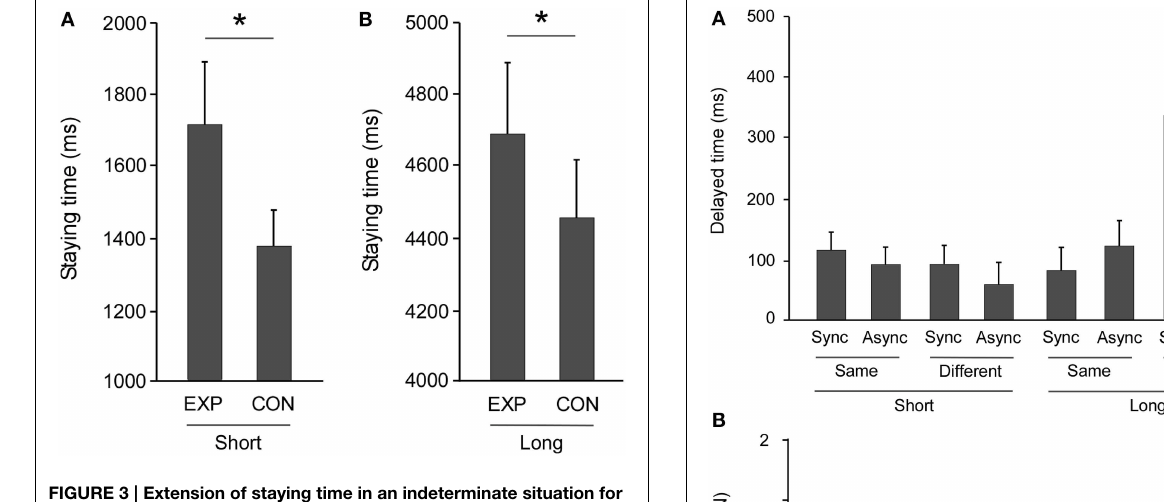
was significant [ F (1 , 16) = 8 . 821, p = 0 . 009, η 2 = 0.355].